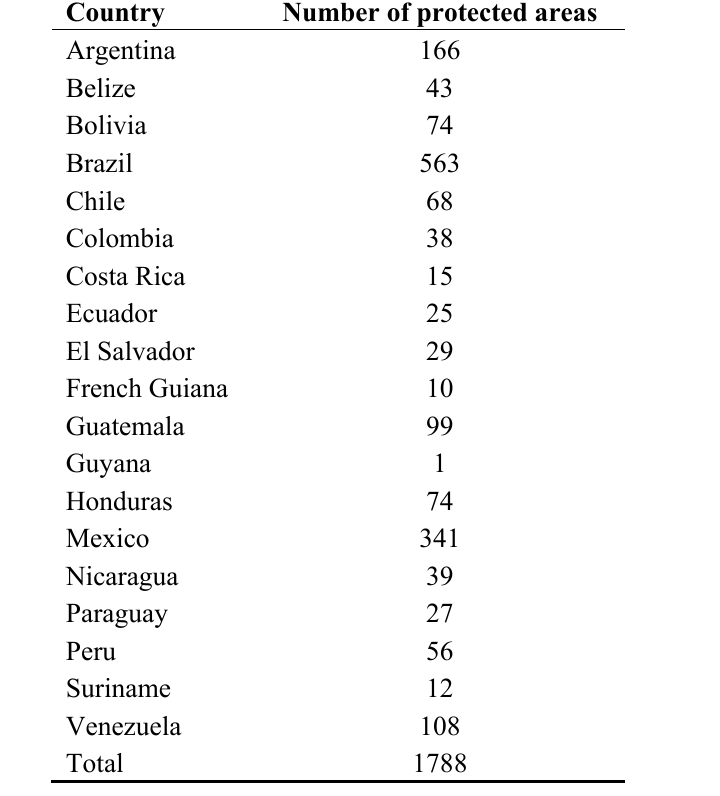
Table 1. Country and number of protected areas included in the analysis. Country Number of protected